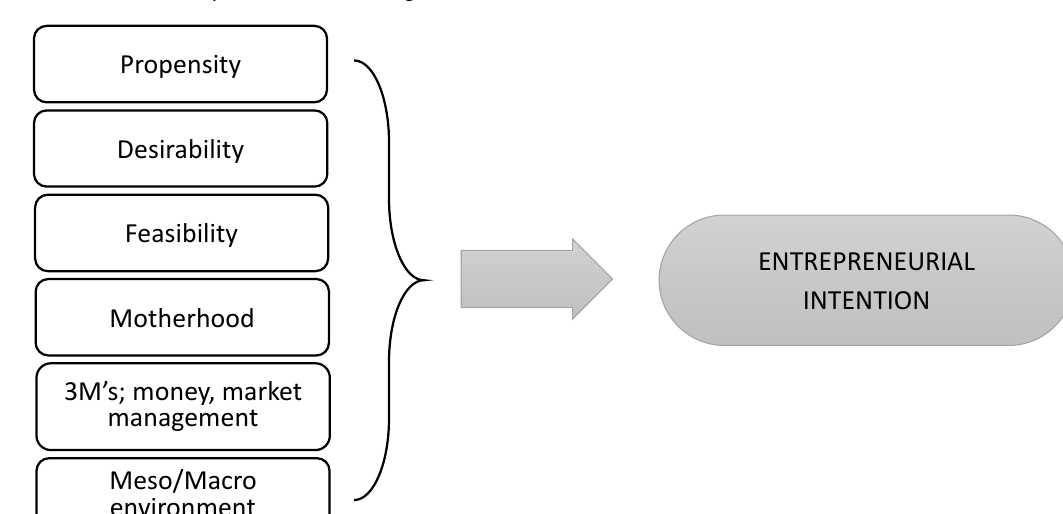
Figure 4. Framework for Data Analysis